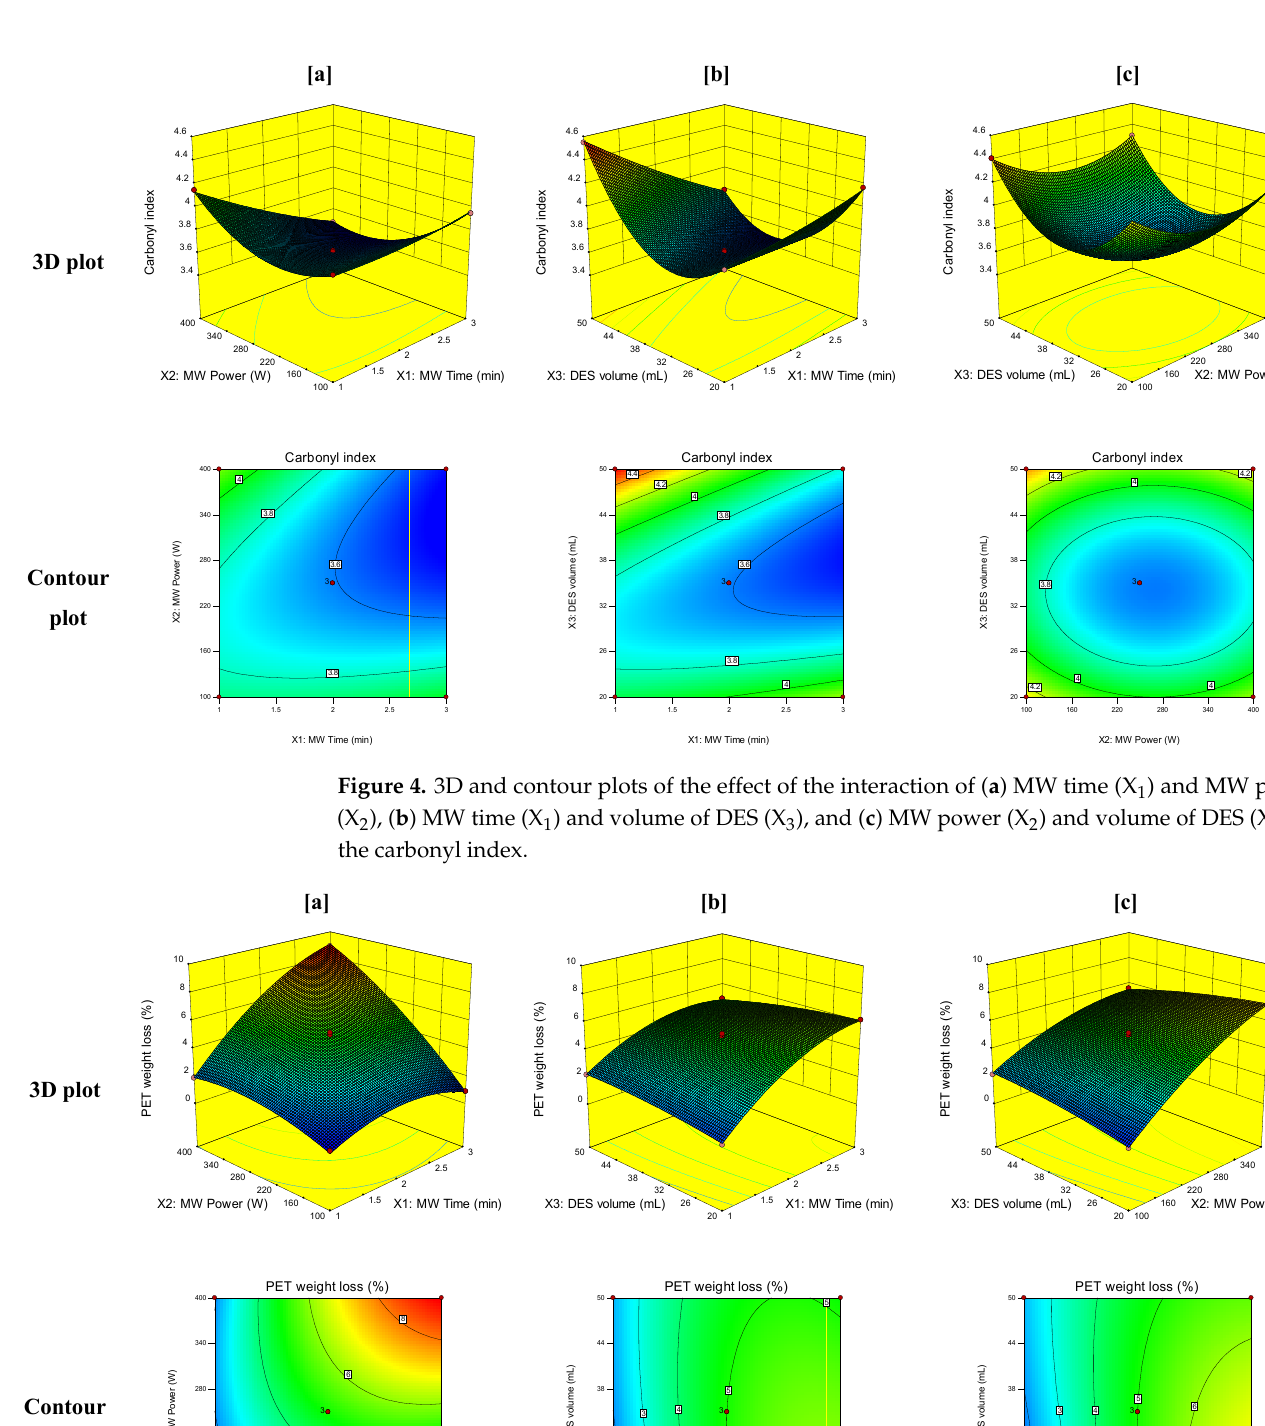
Figure 3. 3D and contour plots of the effect of the interaction of ( a ) MW time (X 1 ) and MW power (X 2 ), ( b ) MW time (X 1 ) and volume of DES (X 3 ), and ( c ) MW power (X 2 ) and volume of DES (X 3 ) on the crystallinity index.